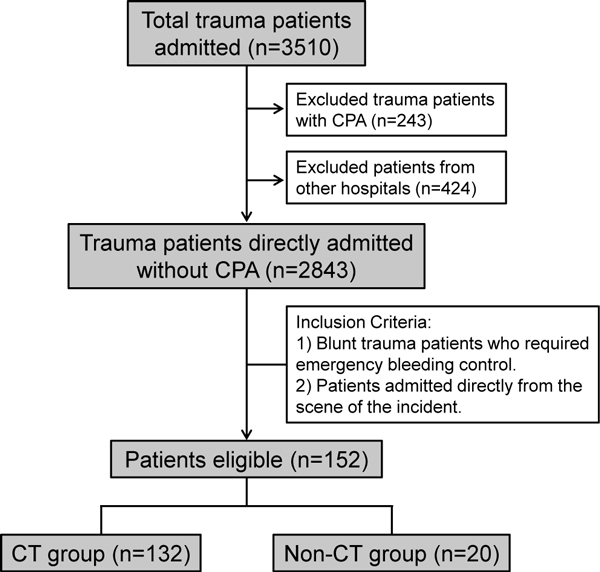
Patient flow diagram. CPA, cardiopulmonary arrest.